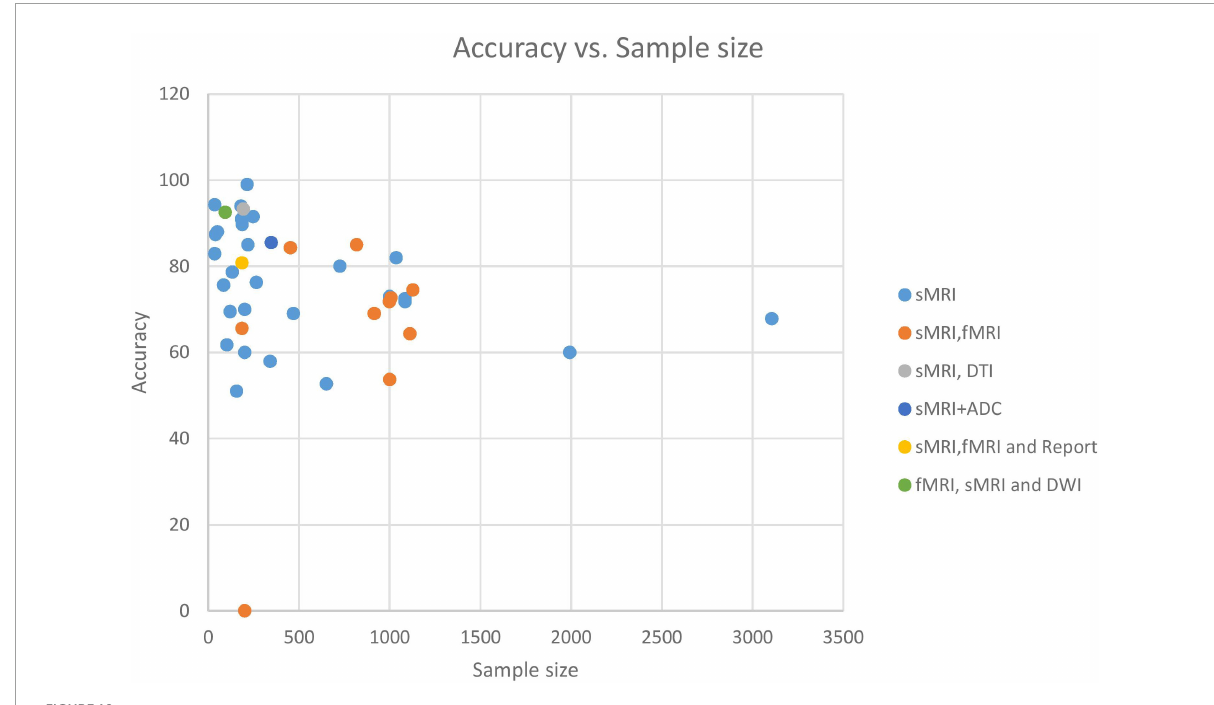
FIGURE10 Shows relationships between the sample size and the accuracy of the studies.